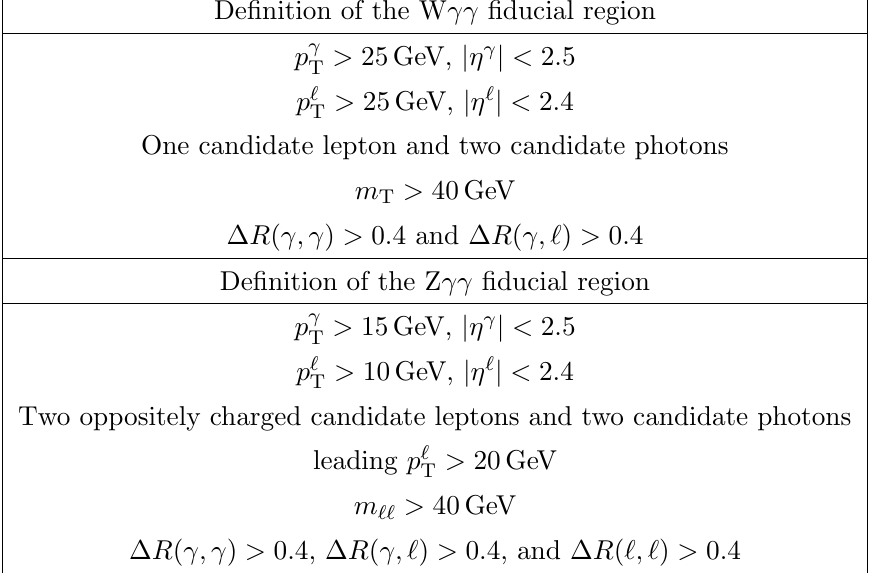
replaced by the neutrino T